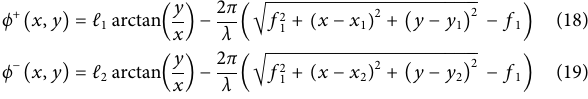
Frontiers in Physics |